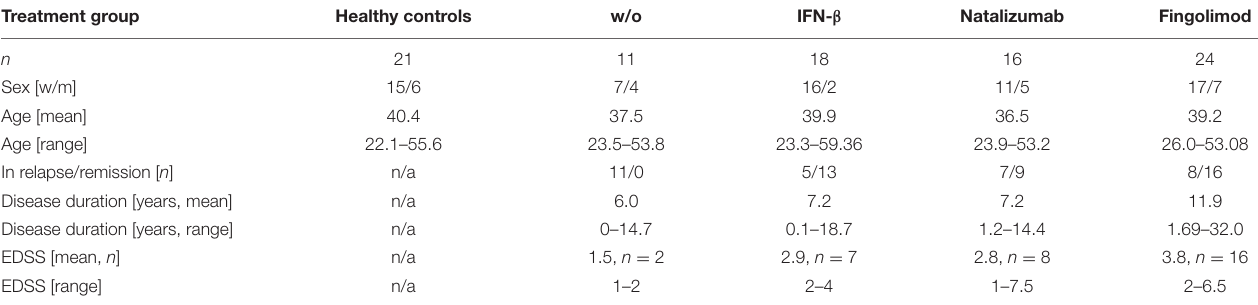
TABLE 1 | Demographic details of RRMS patients and healthy controls. Treatment group Healthy controls w/o Natalizumab